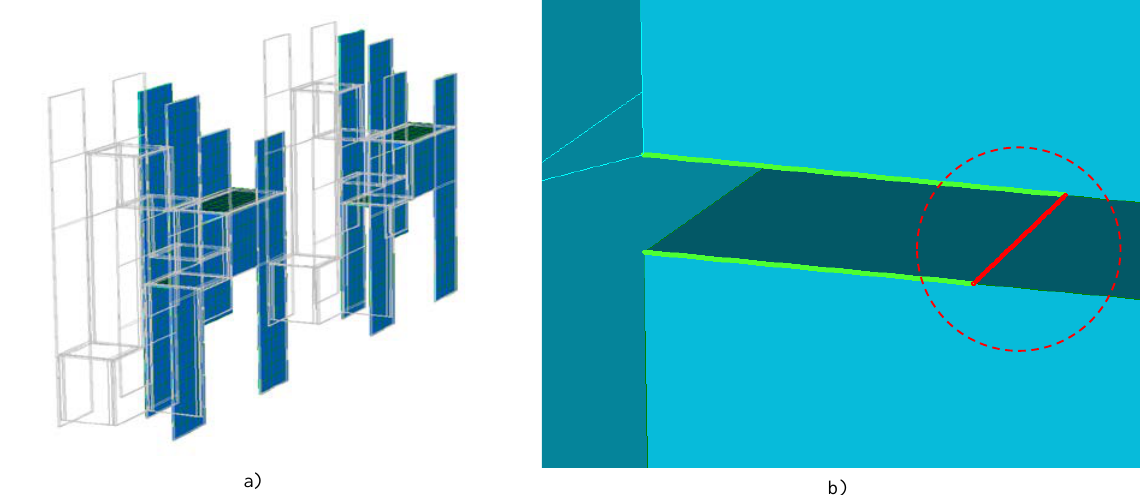
Fig. 3: 3 Isometric view of the chosen part for FE- analysis of the overall structure